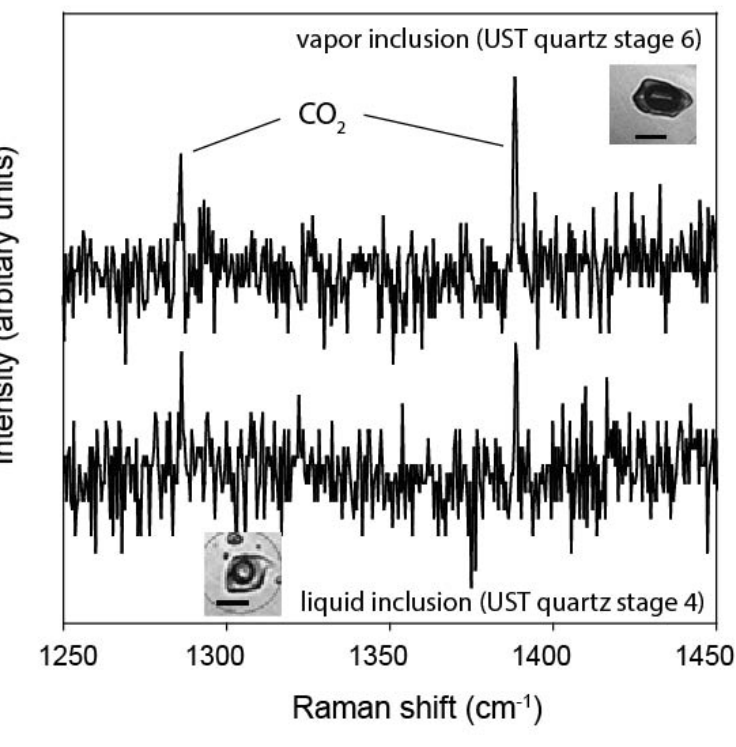
Figure 6. Raman spectra of vapor-rich and liquid-rich inclusions in the UST quartz showing CO 2 peaks. The Raman spectrometer laser was focused on the vapor bubble part of the inclusions.